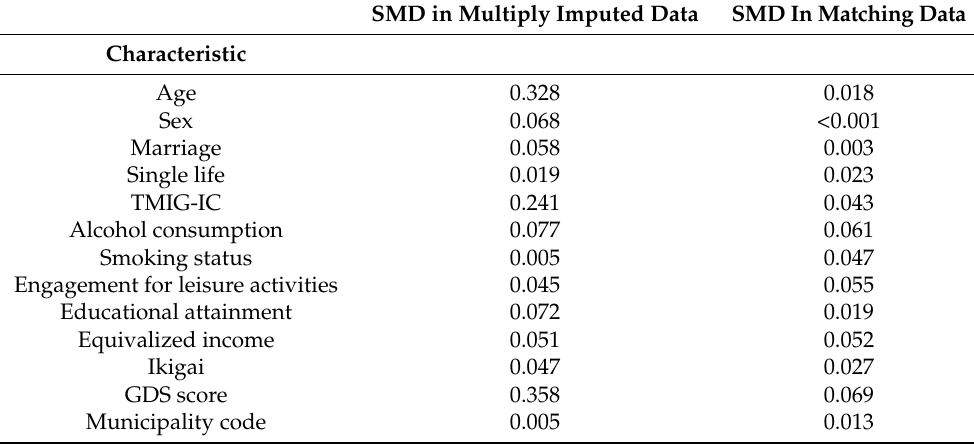
Table 2. Standardized mean differences before and after propensity score